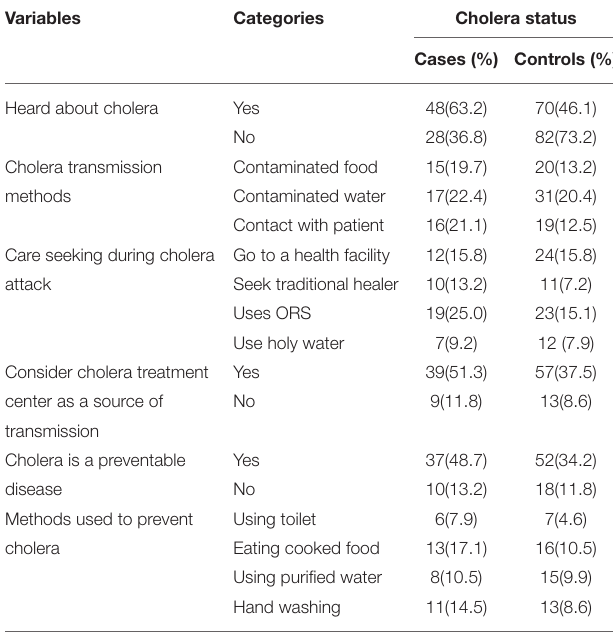
TABLE 2 | Knowledge of cholera and care-seeking habit in Somali region, 2019.